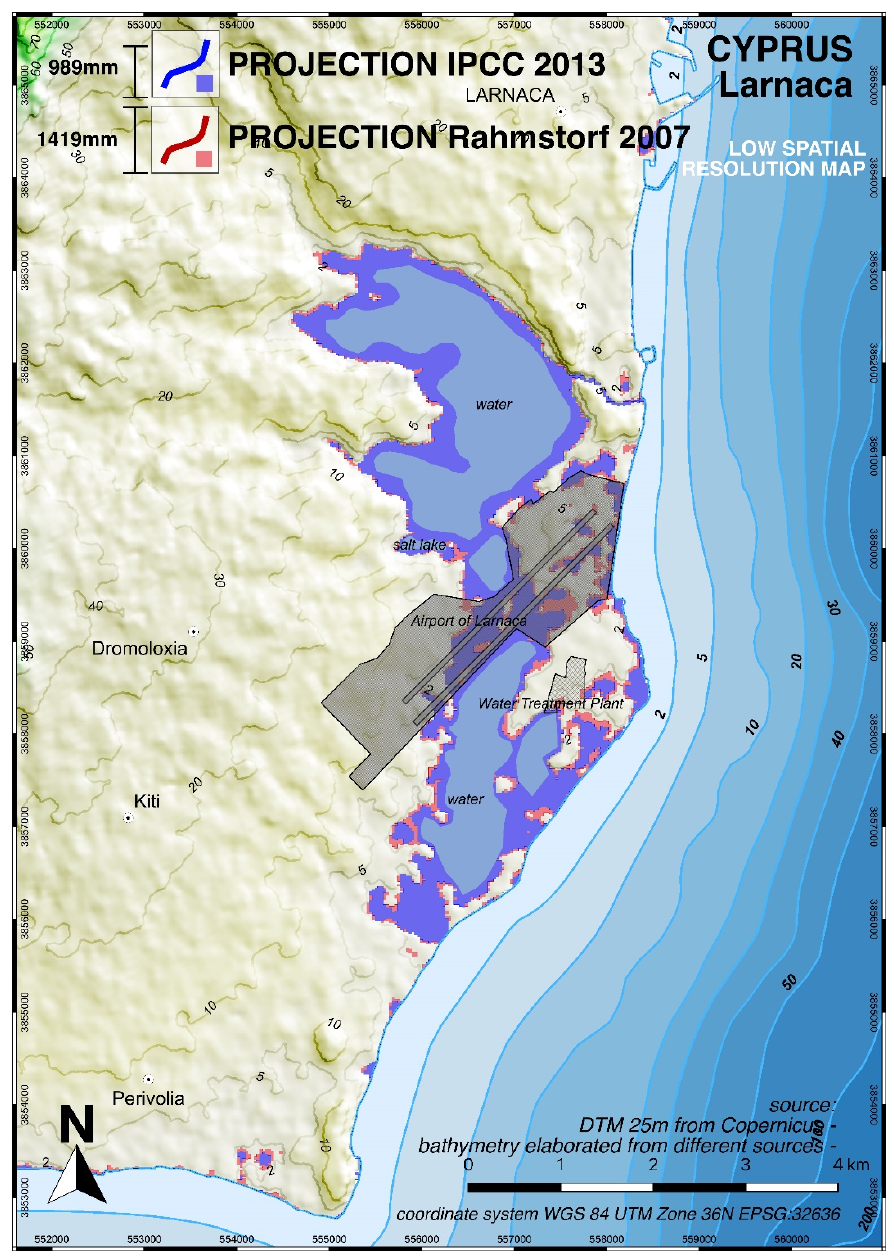
Figure 5. Map 11 Larnaka (Cyprus), see also Figure 1 for location). The potential submersion